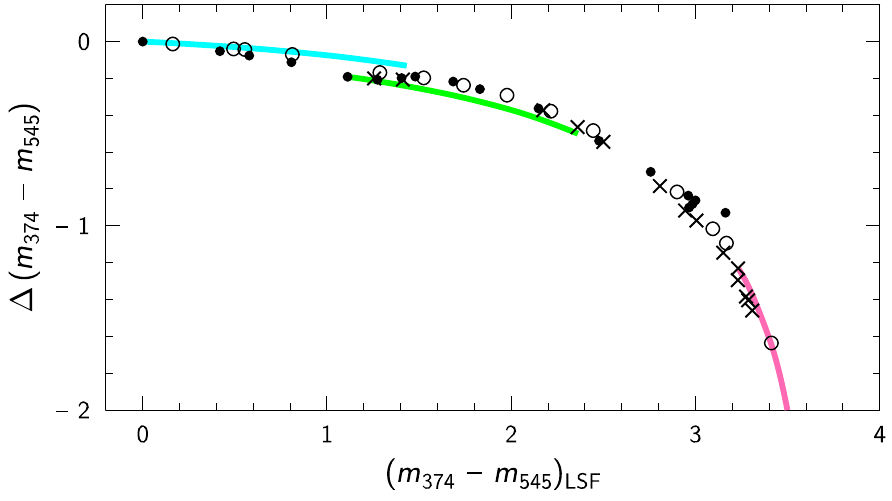
Fig. 8b. The same as in Figure 8a but for the color index m 374 – m 545